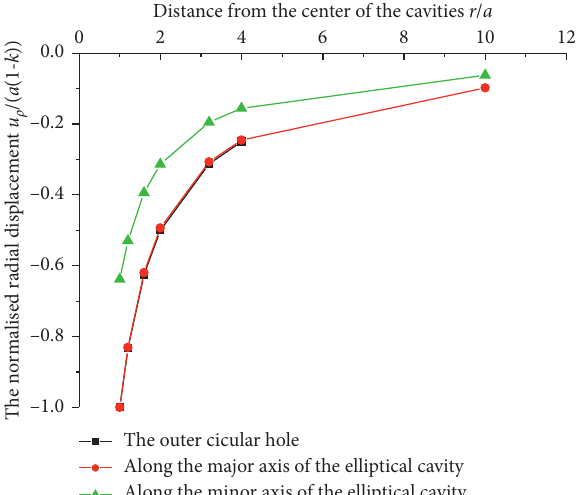
Figure 5: Distribution of the radial displacement of the soil due to the radial displacement at the boundaries of the cavities.